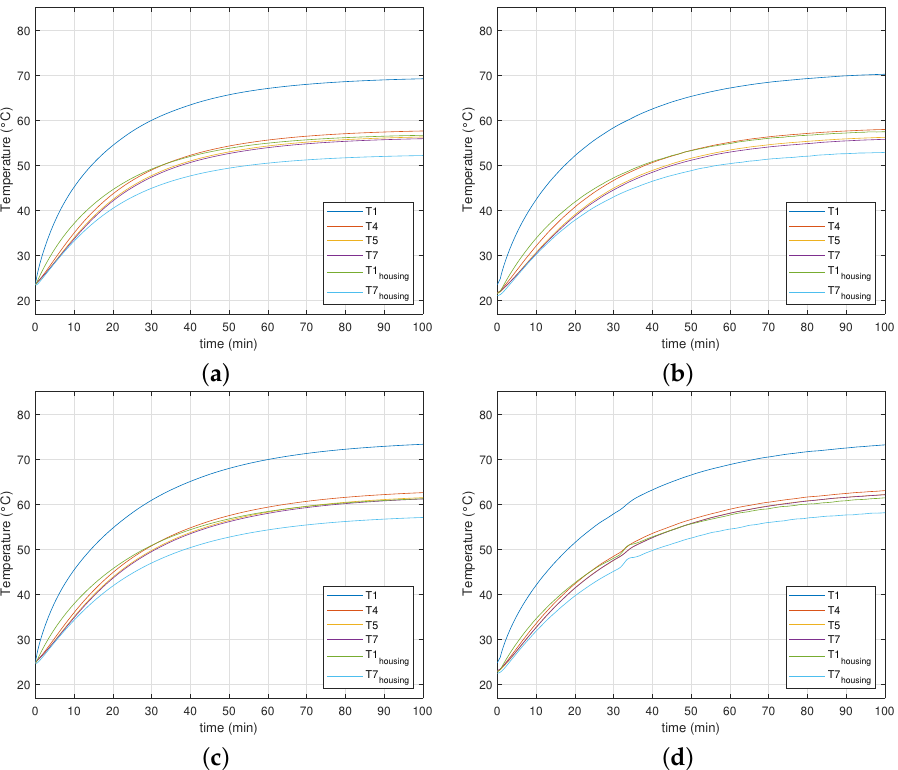
Figure 12. Transient temperature evolution at selected locations (see Figure 10) in a stator with anodised aluminium foil winding for a 24 slot, 22 or 26 pole combination. ( a ) Simulated tempera- tures|stator without end-winding ring. ( b ) Measured temperatures|stator without end-winding ring. ( c ) Simulated temperatures|stator with end-winding ring. ( d ) Measured temperatures|stator with end-winding ring.